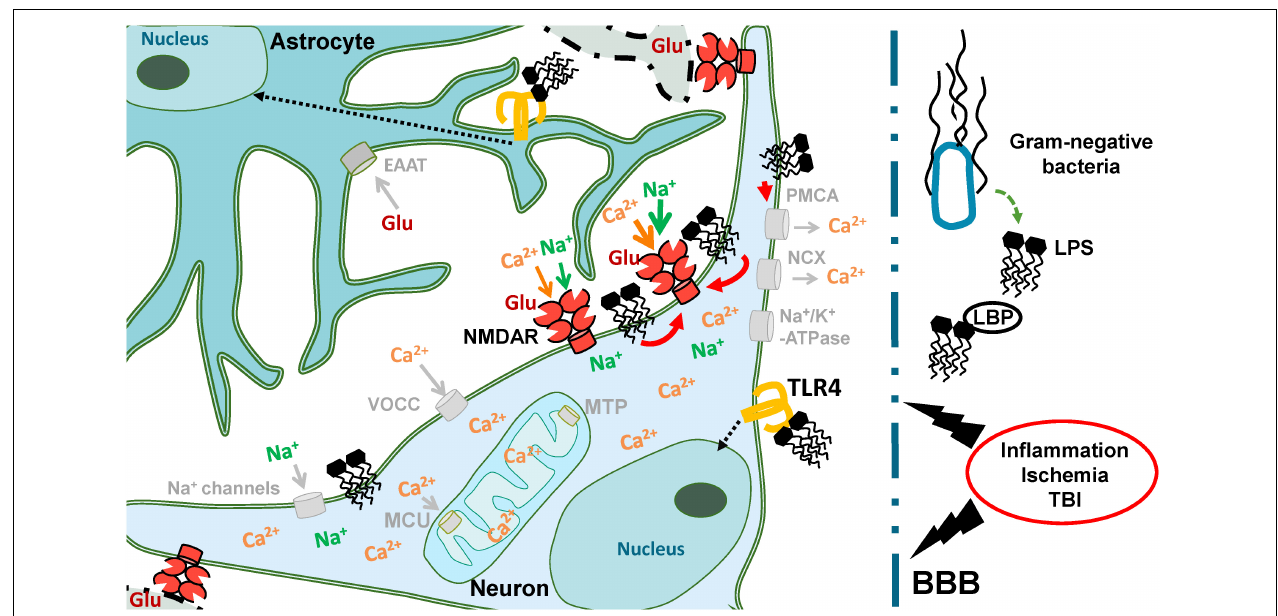
FIGURE 10 | Neuronal ion homeostasis is supported by activity of various protein molecules located in the plasma membrane: ion channels, pumps, secondary transporters. The interaction of LPS with TLR4 can activate intracellular cascades leading to inflammation (black dotted arrows). Concerning the amphiphilic properties LPS is able to influence the rheological properties of plasmalemma and the protein molecules located in it. Our data demonstrates that such effects of LPS could enhance the ionic homeostasis disturbance caused by hyperstimulation of the ionotropic receptors of Glu in case of Ischemia or TBI (red arrows).